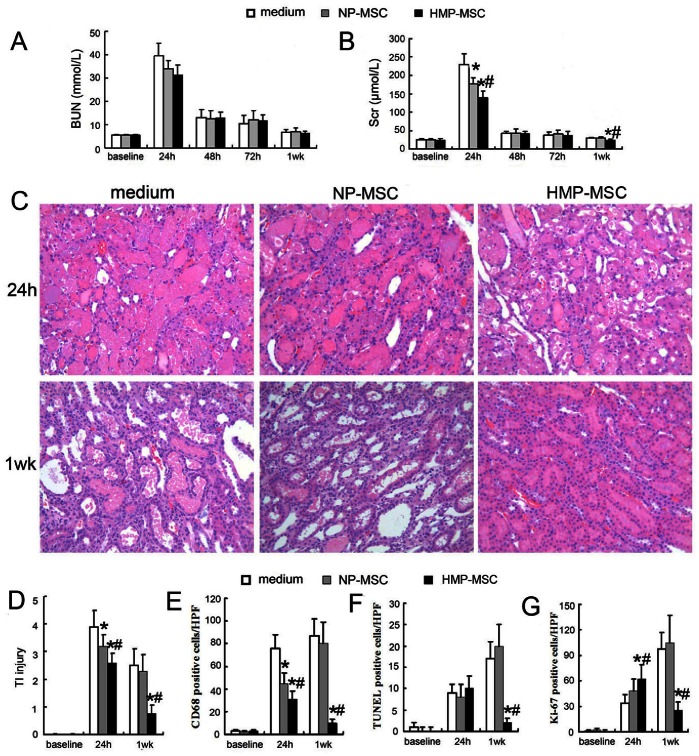
HMP-MSC injection protected the kidney from I/R injury better than NP-MSC administration.Renal function was evaluated by determining (A) Scr and (B) BUN levels in the week following I/R AKI. Administration of HMP-MSC had a better maintained renal function than NP-MSC and vehicle treatment at 24 h and 1 wk following transplantation. (C) Renal morphological changes after I/R injury (H&E-stainning, magnification ×200). (D) Tubulointerstitial (TI) injury score in the cortex and outer medullar region. HMP-MSC administration significantly lowered TI injury score at 24 h and 1 wk after reperfusion. (E) HMP-MSC rats showed lower numbers of CD68 positive macrophages than medium and NP-MSC groups at 24 h and 1 wk after reperfusion. (F) TUNEL positive apoptotic cells in the three groups were not significantly different at 24 h after injection, but it was significantly lower in HMP-MSC group than in medium and NP-MSC groups 1 week after injection. (G) The number of Ki-67 positive proliferating cells was higher in HMP-MSC group at 24 h after injection with most of these cells localized in tubules (Figure 10). Conversely, the number of Ki-67 positive cells was lower in HMP-MSC group 1 week after injection with most of the remaining located in interstitium (Figure 10). *P<0.05, vs medium; #P<0.05, vs NP-MSC.